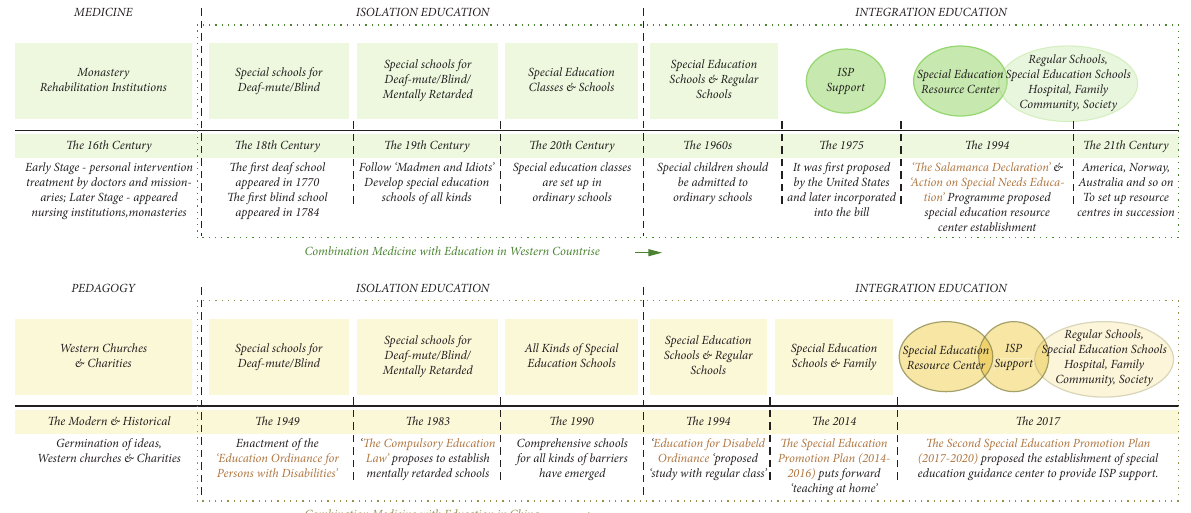
Figure 1: Development stages of integrated education.